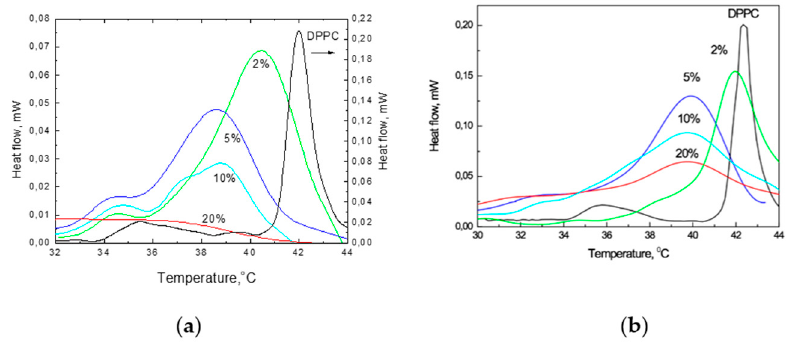
Figure 6. Thermograms of mixtures of DPPC with 0, 2, 5, 10, and 20 mol% of TS (the heat flow scale on the right is related to pure DPPC only) ( A ) and Toc at 0, 2, 5, 10 and 20 mol% ( B ).